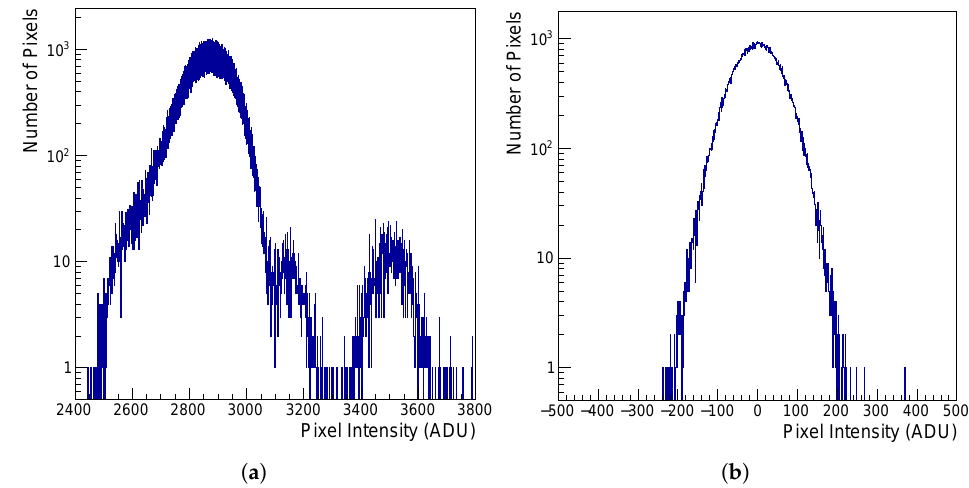
Figure 10. Analogue-to-Digital Unit (ADU) distribution of all pixels of an exposure frame before ( a ) and after ( b ) bias